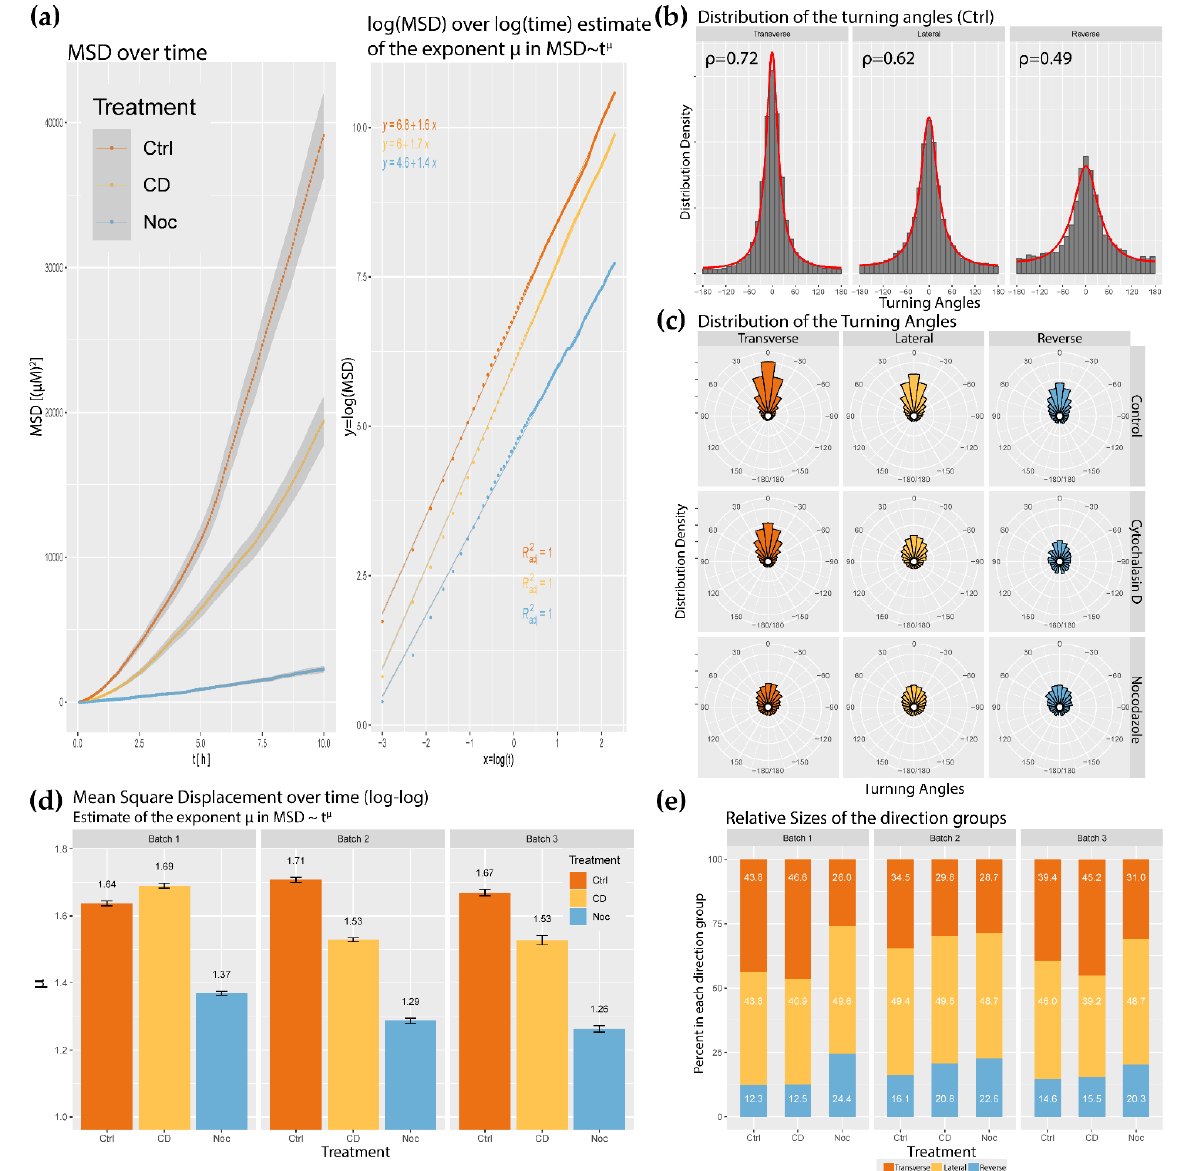
Figure 5. ( a ) Plot of the mean squared displacement (MSD) over time for an ensemble of tracked ECs ( n = 269). The same plot is transformed into log-log coordinates to estimate the exponent µ in MSD = at µ with a linear regression. Note that the log(x) function in these calculations refers to the natural logarithm (base e ). Note that the standard linear regression problem utilizes the line slope and y-intercept to minimize the error in the dataset; ( b ) Normalized histogram of empirically measured turning angles and the wrapped Cauchy probability density. This was performed on the previously denoted directional regions for cytoskeletal disruptions (Ctrl—control; CD—50 ng/mL cytochalasin D; Noc—50 ng/mL nocodazole). The number on the top left-hand corner represents the maximal likelihood estimate of the concentration around 0 ◦ parameter ρ to produce the observed turning angle distributions; ( c ) Histograms from ( b ) represented radially. Positive angles correspond to counter- clockwise rotations from the 0 axis, consistent with the convention used in ( b ); ( d ) Estimated exponent µ in MSD ∼ t µ comparison by biological replicate (error bars correspond to the 95% confidence interval). ( e ) Relative sizes direction groups for each wound healing assay and cytoskeletal